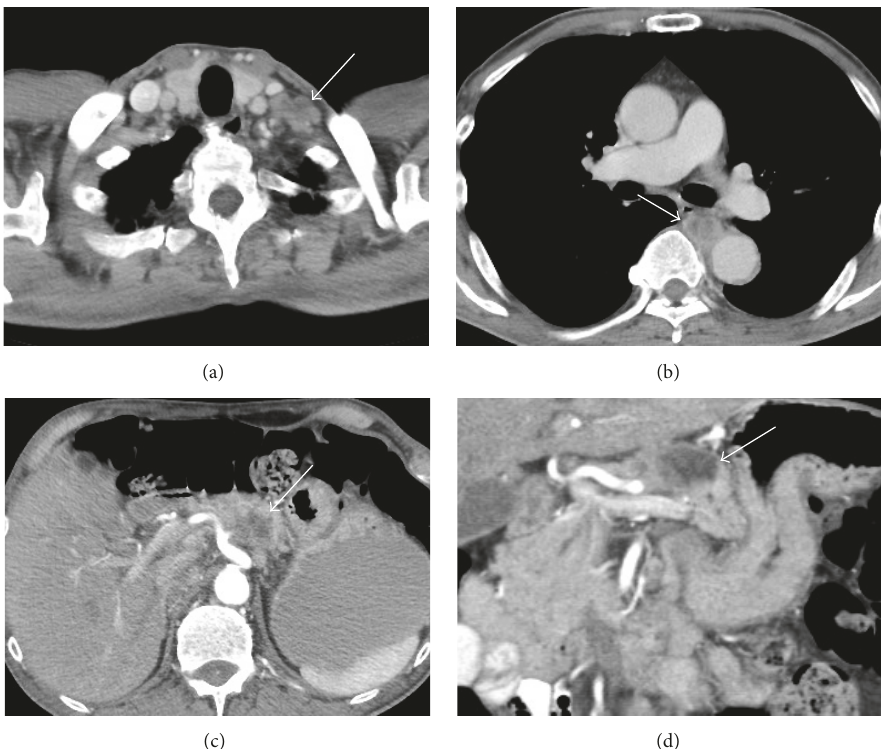
Figure 1: Computed tomography. (a) A conglomerate of lymph nodes in the left supraclavicular fossa measuring 3cm (arrow). (b) A 2 cm left mid lung mass posterior to the left main stem bronchus (arrow). (c and d) A 3.8 cm hypodense mass in the pancreatic body with associated ill-defined soft tissue inseparable from the distal celiac axis and its branches